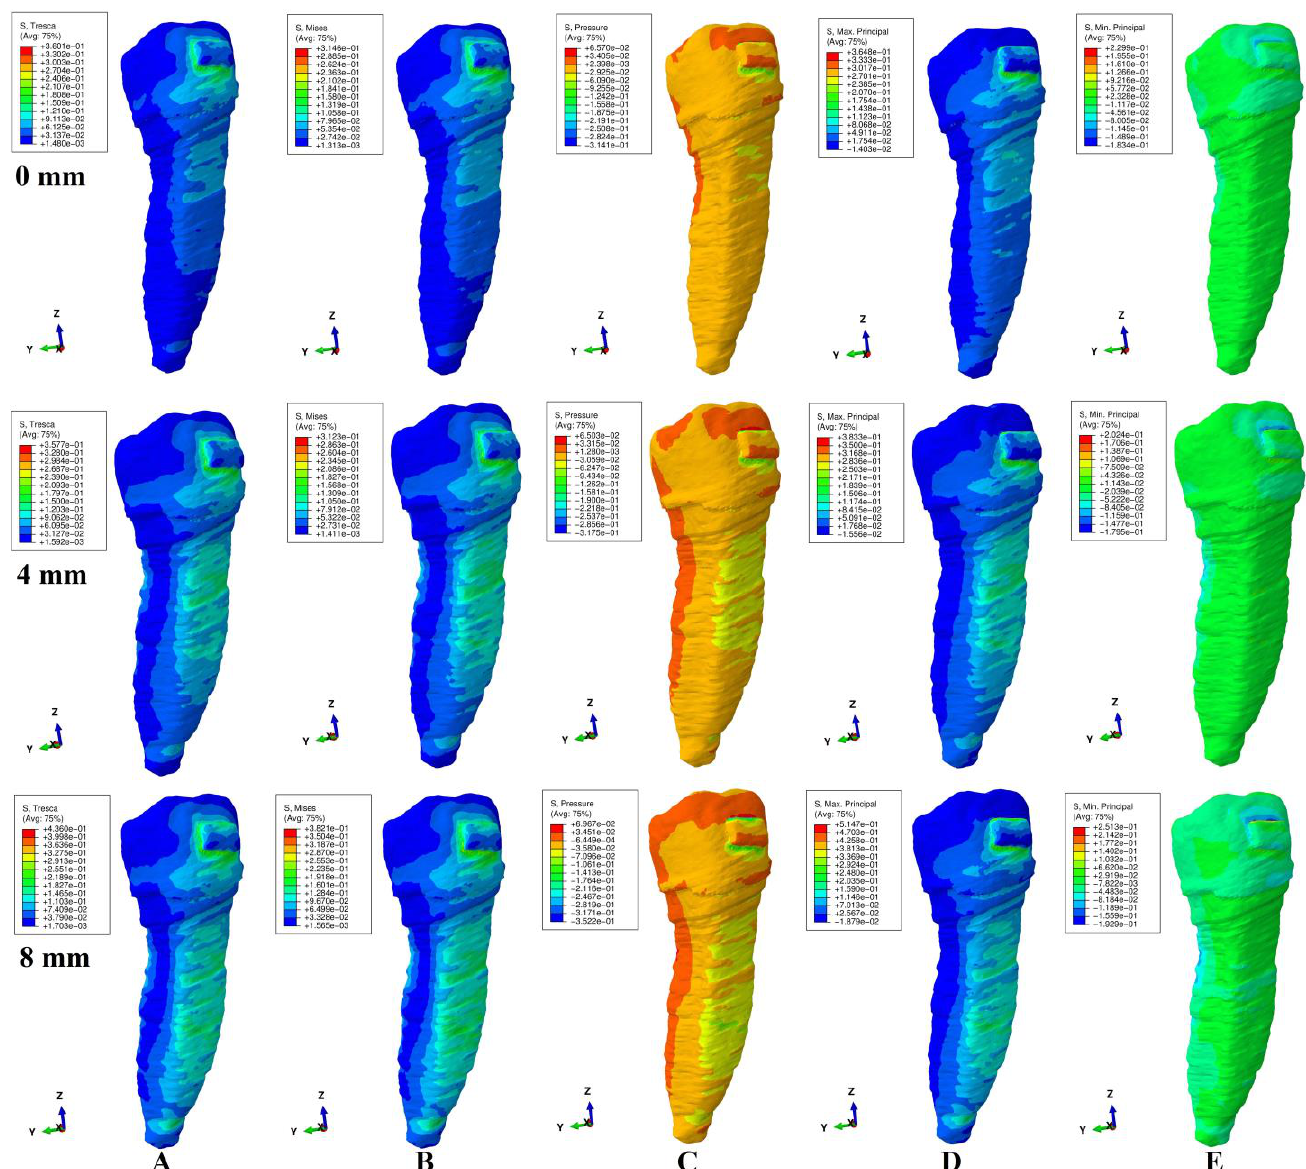
Figure 3. Comparative stress display of the five failure criteria in intact, 4 mm and 8 mm periodontal breakdown for the extrusion movement under 0.5 N of load: ( A ) Tresca; ( B ) Von Mises; ( C ) Pressure; ( D ) S1; ( E ) S3.